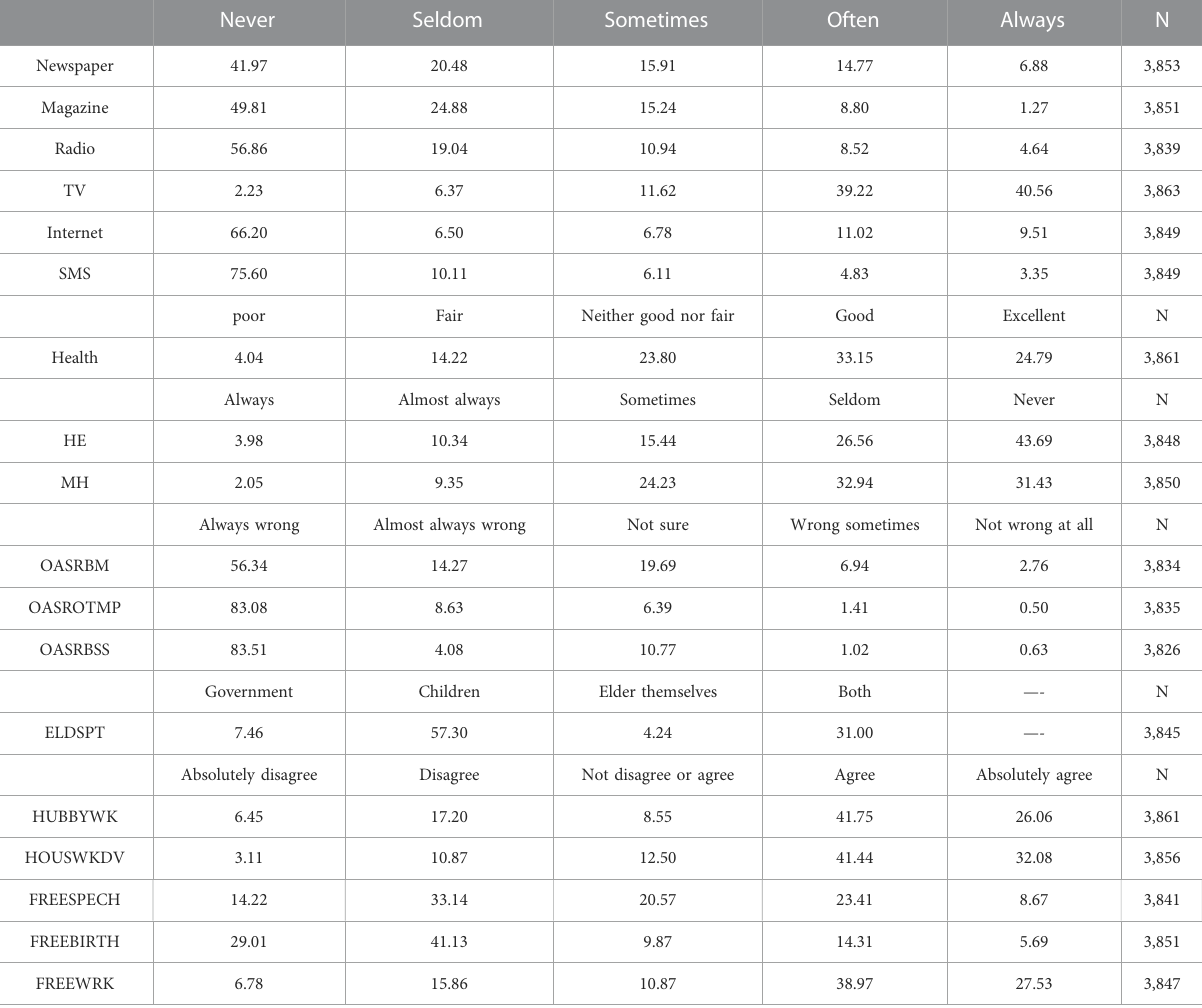
TABLE 3 Percentages of media contact, health condition, and individualism. Never